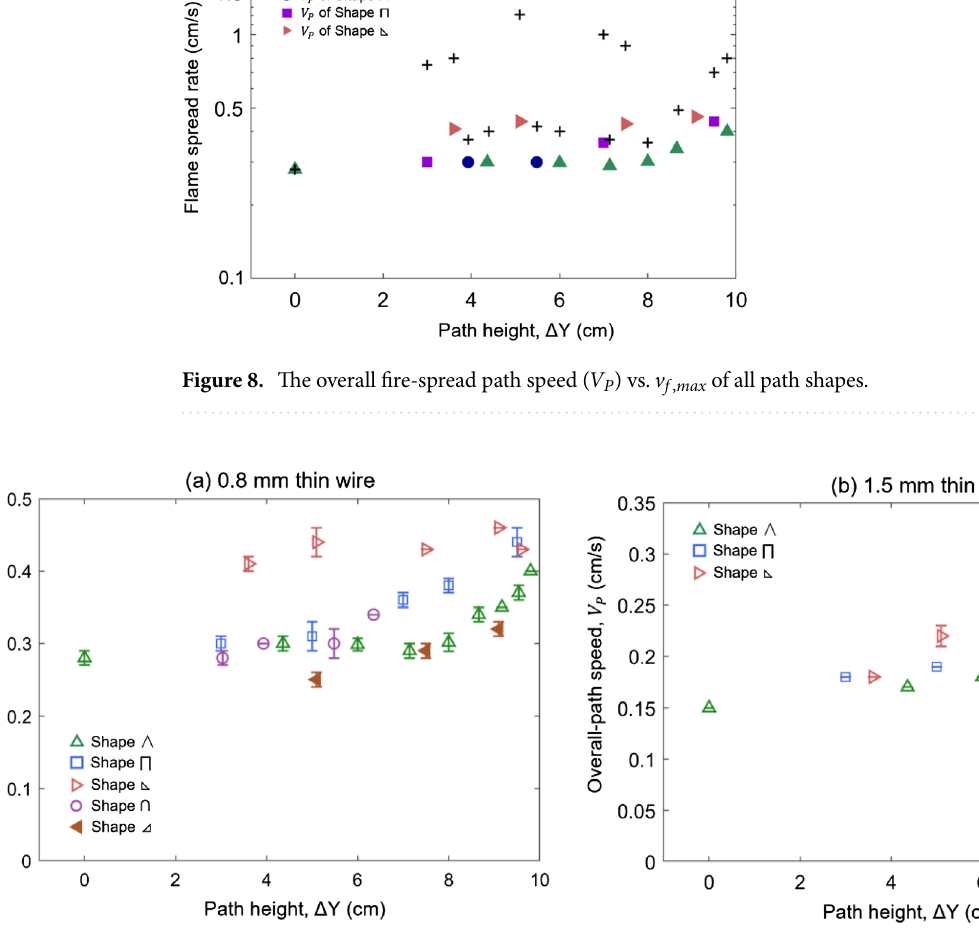
Figure 9. The overall fire spread rate ( V P ) for all path shapes varied with the path height for ( a ) 0.8-mm thin wire and ( b ) 1.5-mm thin